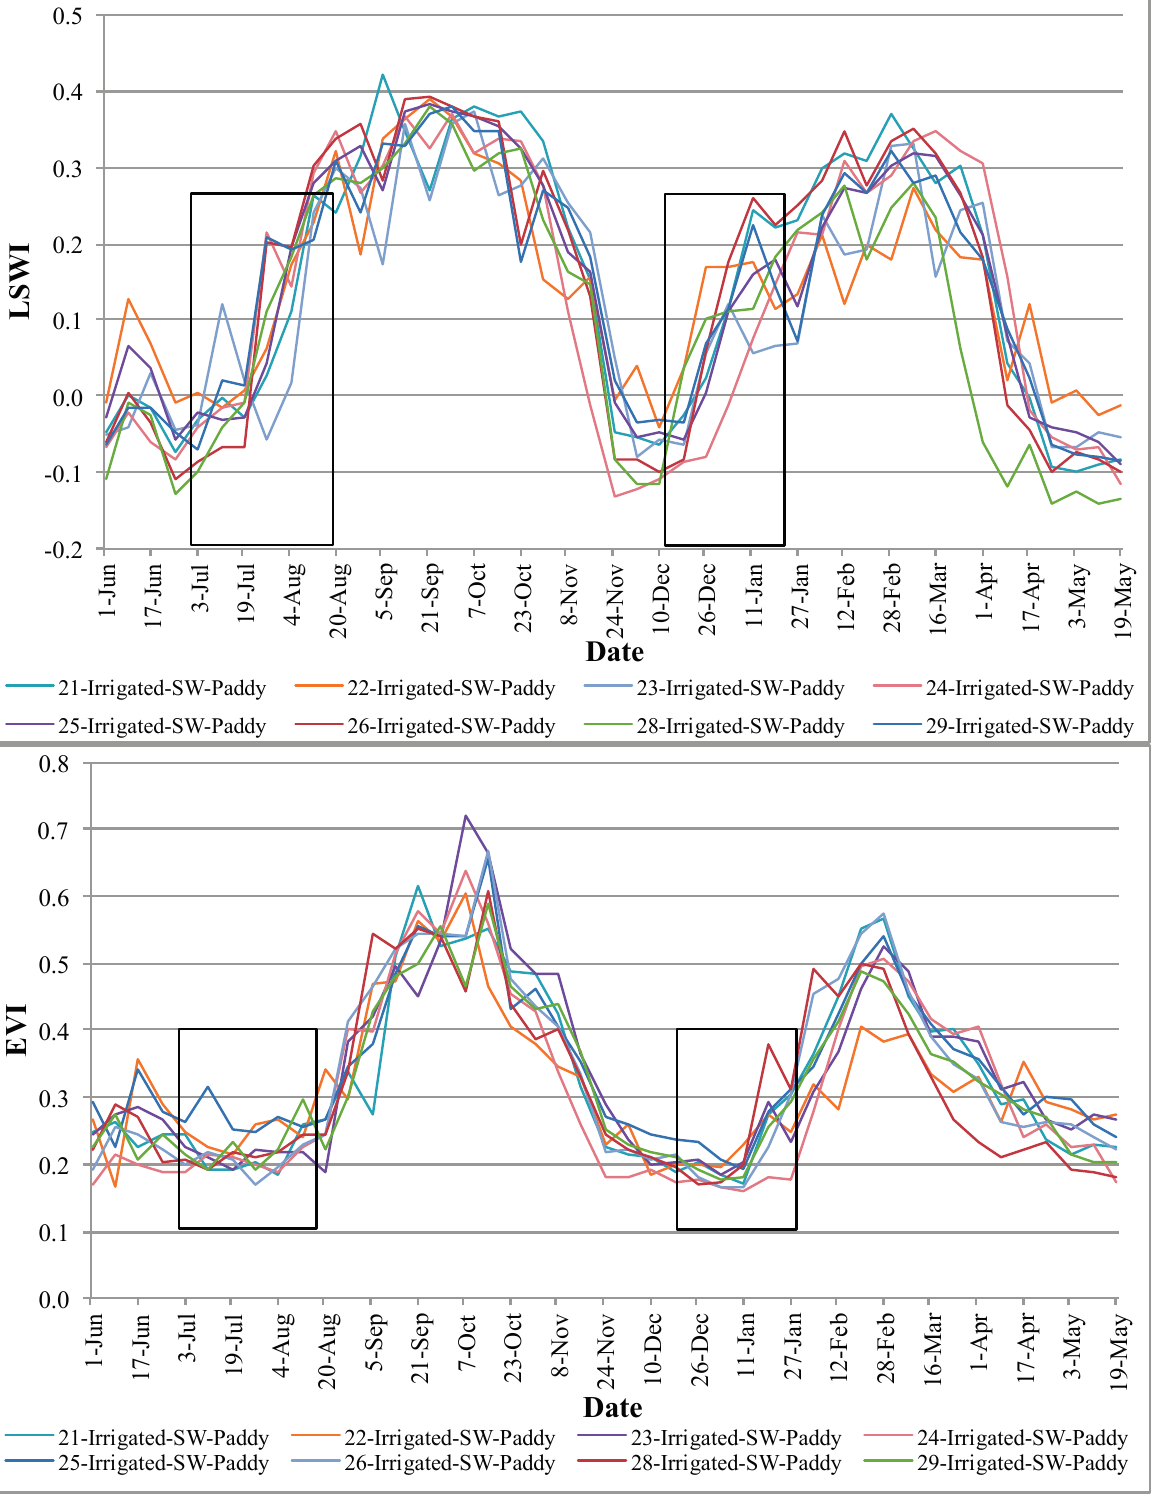
Figure 3. Time series of LSWI and EVI of observed rice fields in the double crop rice zones. The vertical lines represent transplantation season, during this period we can observe inversion of indices for flooded paddy rice